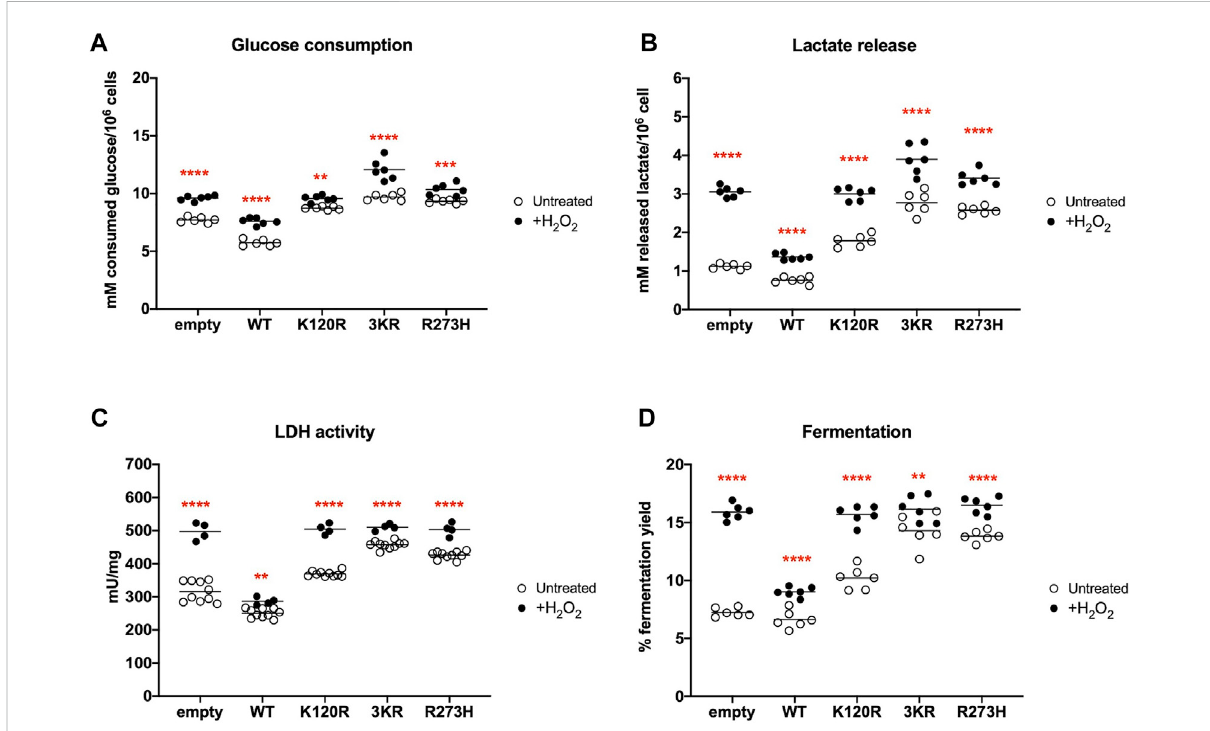
FIGURE 6 Comparison of anaerobic metabolism in H 2 O 2 treated HCT116 TP53 − / − cells with untreated cells expressing p53 WT , p53 3KR , p53 K120R , and p53 R273H proteins. (A) Glucose consumption in untreated (empty dots) and 100 μ M H 2 O 2 treated (black dots) cells. (B) Lactate release in the medium in the same condition as above. (C) LDH activity in the same condition as above. (D) Percentage of lactic acid fermentation yield in the same condition as above. Each panel is representative of at least four independent experiments and data are reported as mean. The red symbols ** and **** indicate signi fi cant differences for p ≤ 0.0031 and p < 0.0001, respectively, betweenthe untreated and 100 μ MH 2 O 2 treated samples. In each panel, the empty dots represent the data from untreated samples depicted in Figure